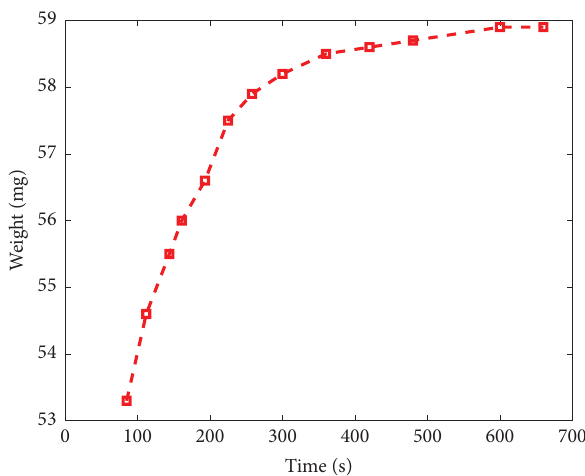
Figure 5: Behavior of gelatin weight as a function of time when the gelatin flm absorbed water molecules from an atmosphere with a 46% RH.